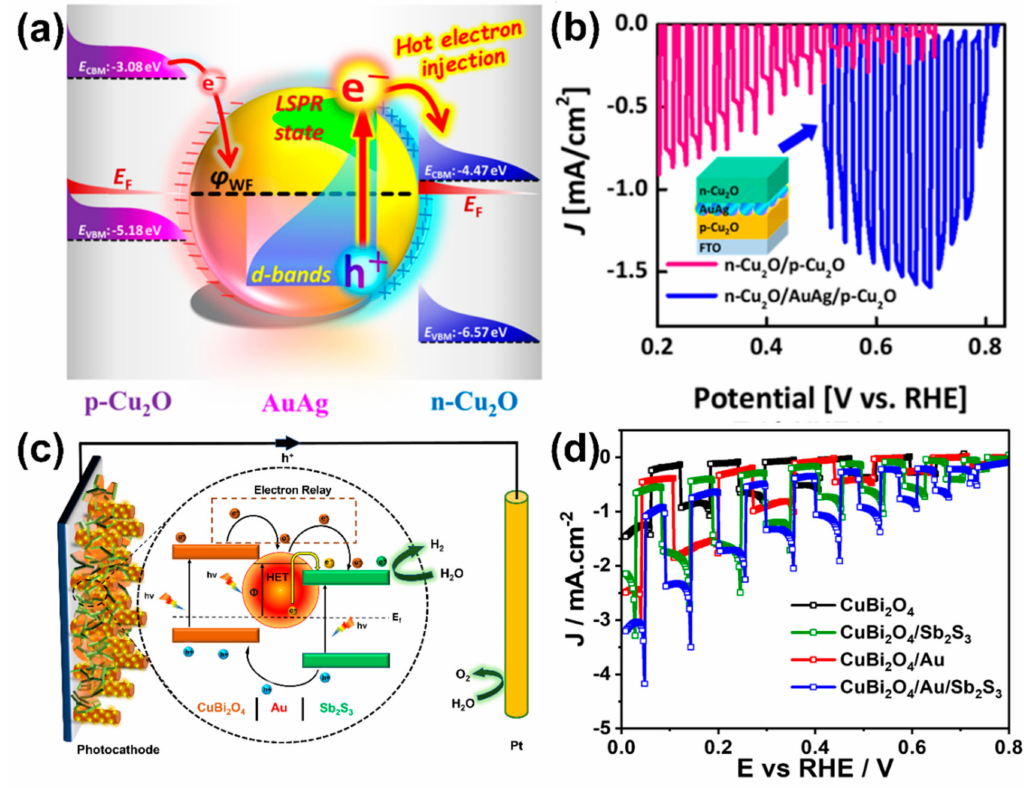
Figure 5. ( a ) Schematic Illustration of the proposed sandwich structure p-Cu 2 O/AuAg/n-Cu 2 O; ( b ) J– V curves of p-Cu 2 O/AuAg/n-Cu 2 O and p-Cu 2 O/n-Cu 2 O photocathodes. Produced with permission of ref. [41]. Copyright 2019, American Chemical Society. ( c ) Schematic Illustration of the charge transfer in the CuBi 2 O 4 /Au/Sb 2 S 3 photocathode; ( d ) J–V curves of the CuBi 2 O 4 , CuBi 2 O 4 /Sb 2 S 3 CuBi 2 O 4 /Au/Sb 2 S 3 photocathode. Produced with the permission of ref. [42]. Copyright 2022, Royal Society of